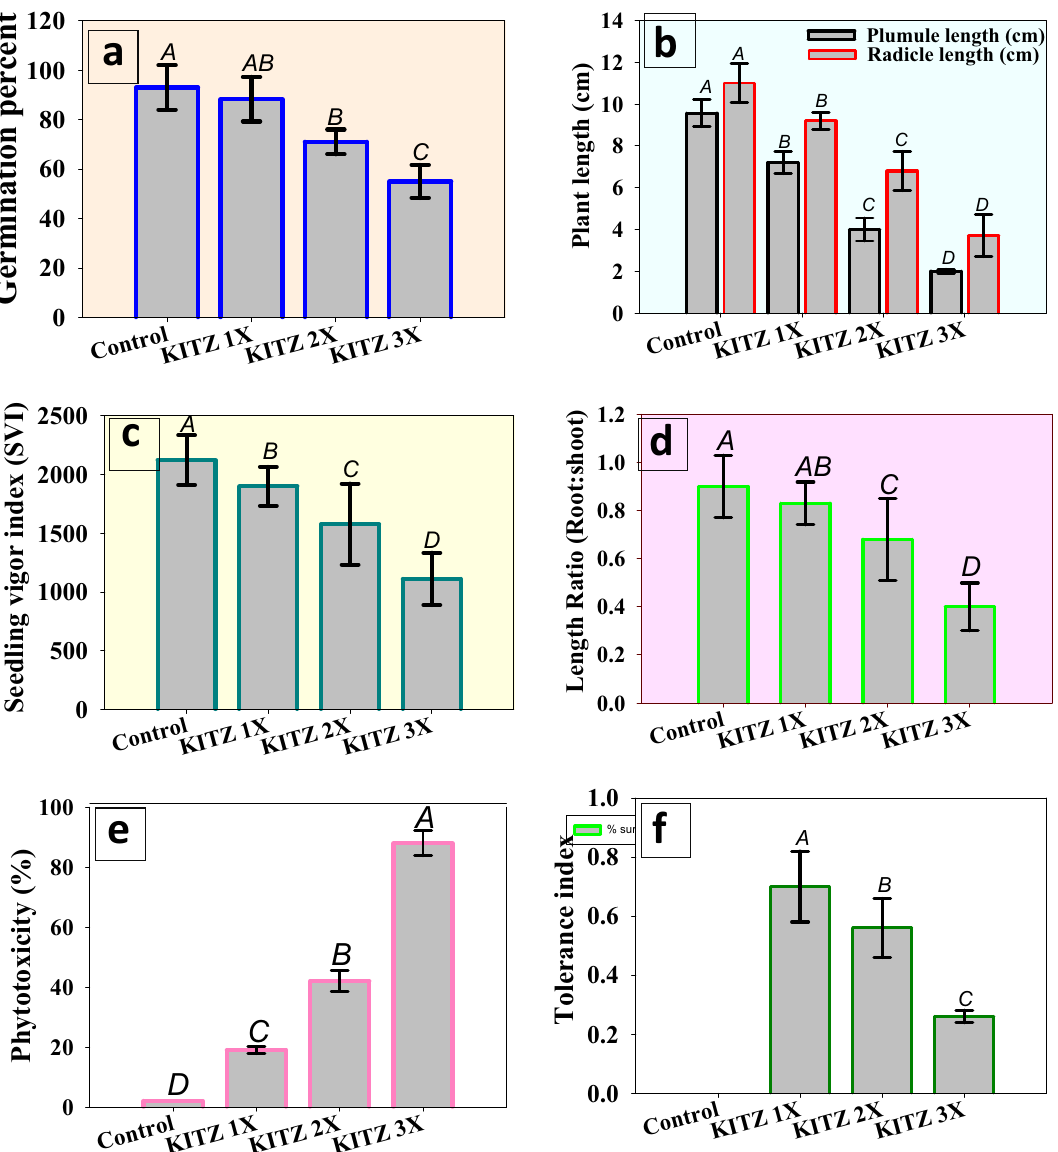
Figure 1. Effect of kitazin on germination percent ( a ), plant length ( b ) vigor index ( c ) root-shoot length ratio ( d ) percent phytotoxicity ( e ) and tolerance index ( f ) of Cicer arietinum seedlings geminated on 0.7% soft agar plates treated with three concentrations of KITZ under in vitro condition. Each bar represents the mean ± S.D ( n = 3) of three replicates where each replicate constituted three plants/pot. Mean values followed by different letters are significantly different at p ≤ 0.05 according to Duncan’s multiple range (DMRT) test whereas error bars represent standard deviation